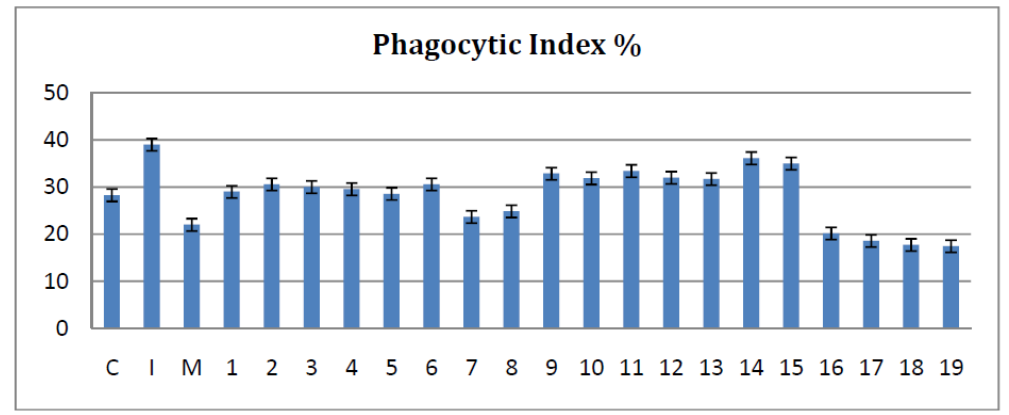
C = negative control; I = inflammation; M = meloxicam.